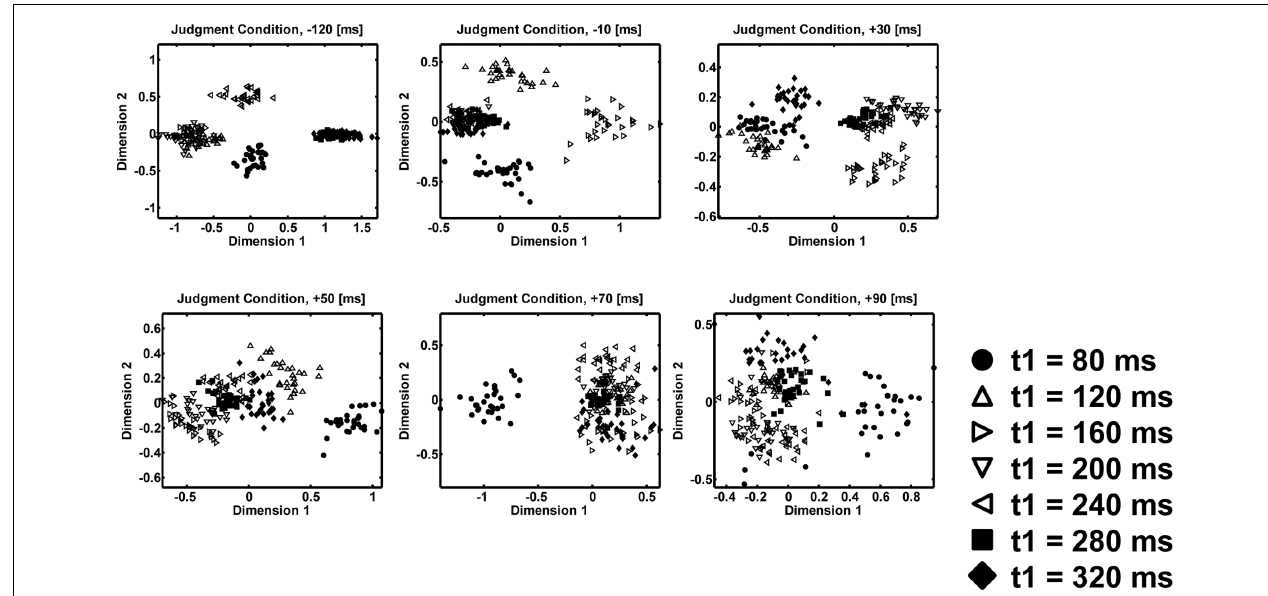
symbols represent perceptually unequal temporal patterns. Open symbols represent perceptually equal temporal patterns.The scatter of a symbol shows the variability across different resampling in bootstrapping ( N = 30).